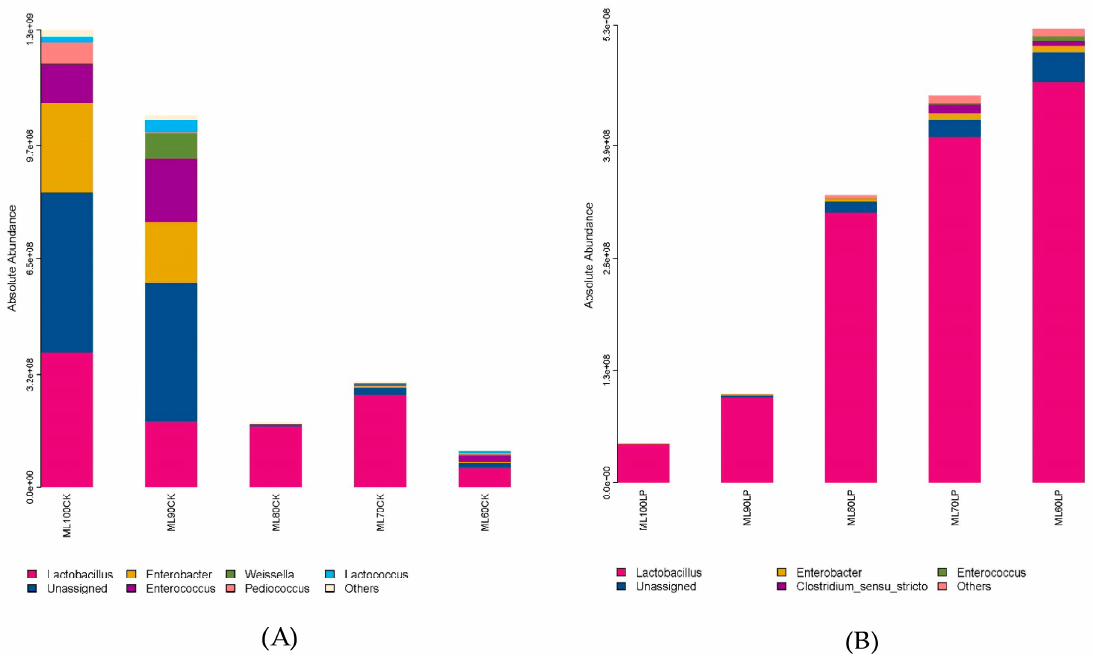
Figure 4. Bar plots of bacterial community structures in non-inoculated ( A ) and inoculated ( B ) silage. CK, silage without inoculation; LP, silage inoculated with L. plantarum A345. The numbers after “ML” indicate proportion of mulberry leaves in silage.